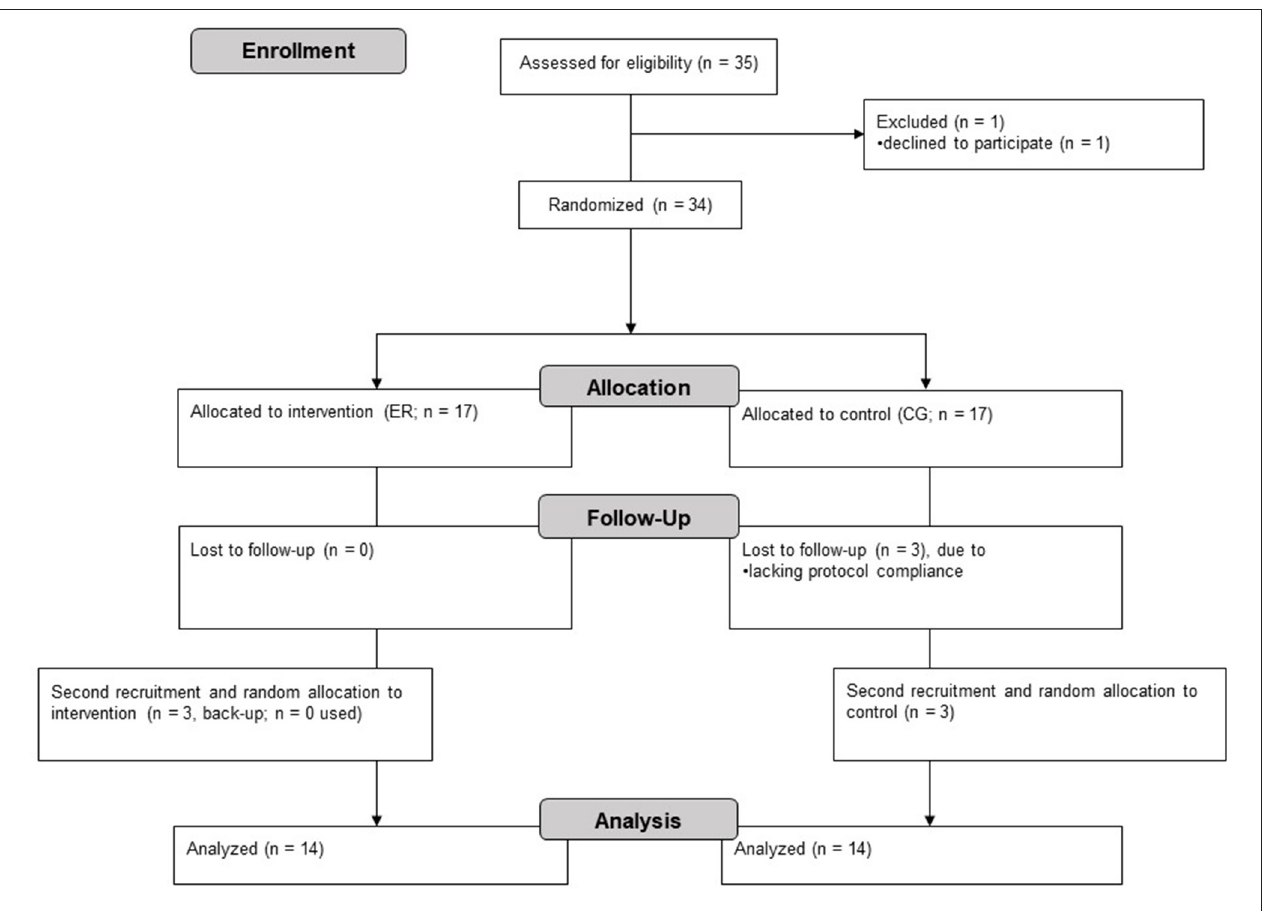
FIGURE 2 | Flow chart of the study conduction following Moher et al. (2001).